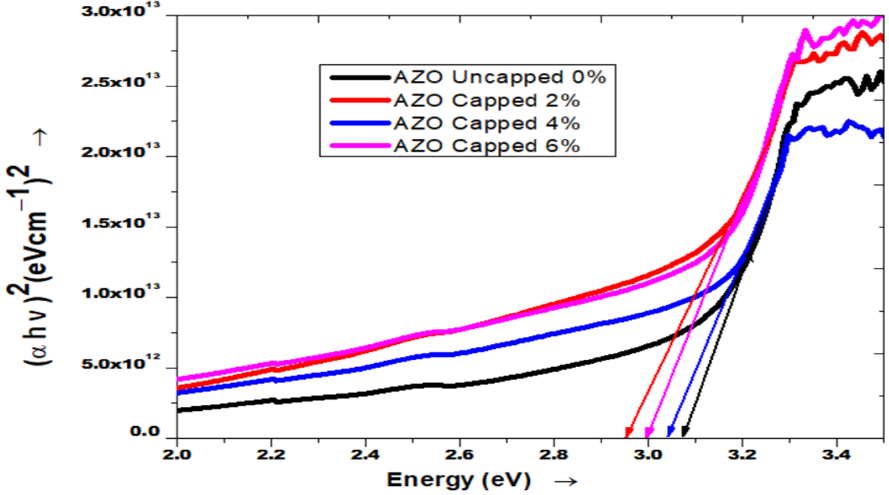
Figure 4. Absorbance spectra and energy band gaps of pure and doped AZO with different concentrations.